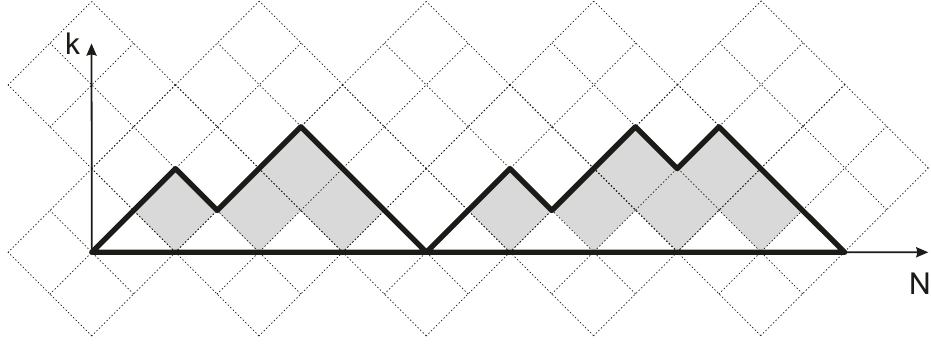
Figure 4 . The N -step Dyck path on a hal(cid:13)ine k (cid:21) 0 with (cid:12)xed area below the path measured in full